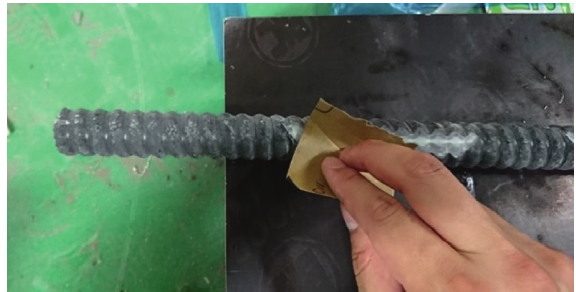
Figure 6: Sanding operation for attaching strain gauges.